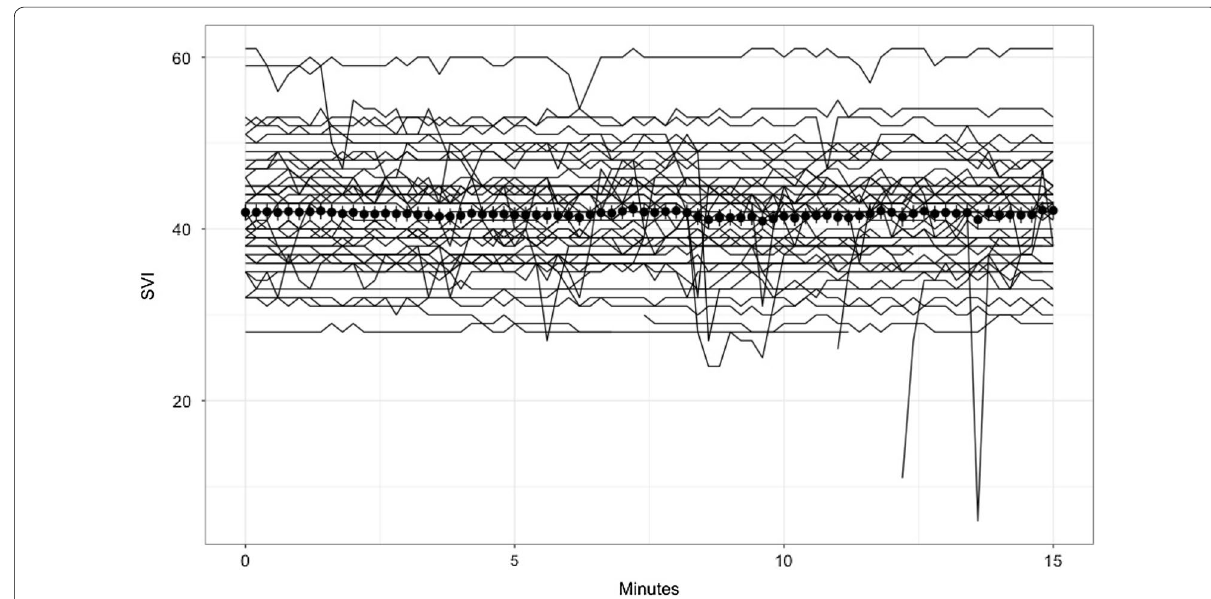
Fig. 1 Spaghetti plots: Individual values (solid lines), mean (circle) and standard deviation of stroke volume index (SVI) during the 15 min of